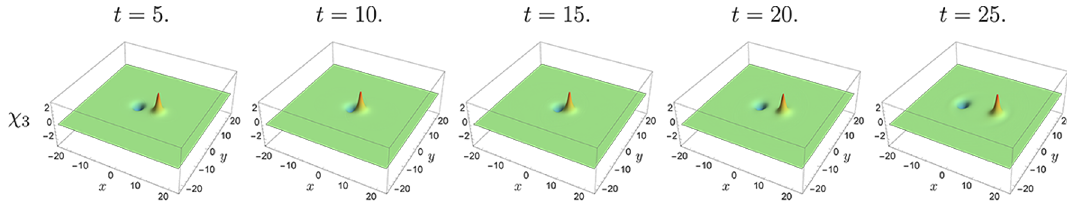
Figure 24 . Snapshots of the χ 3 field for the head-on collision of type II anti-parallel non-Abelian vortices with initial velocity u = 0 . 5 . The vortices bounce-back due to the repulsive force acting between type II